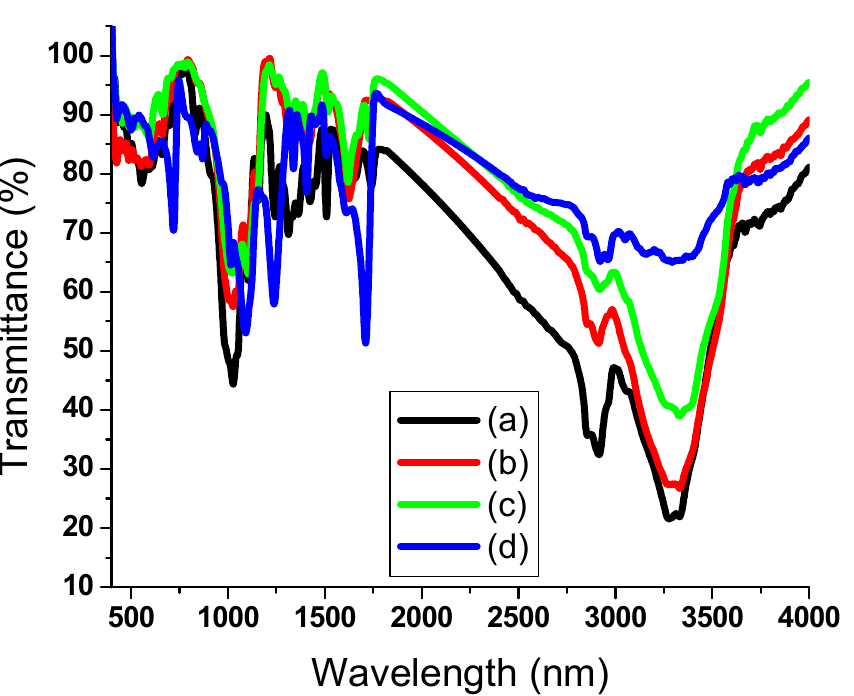
Figure 2. FT-IR spectra of pristine and treated cellulosic fabrics; S 0 (a), S 1 (b), S 8 (e), and S 12 (f).